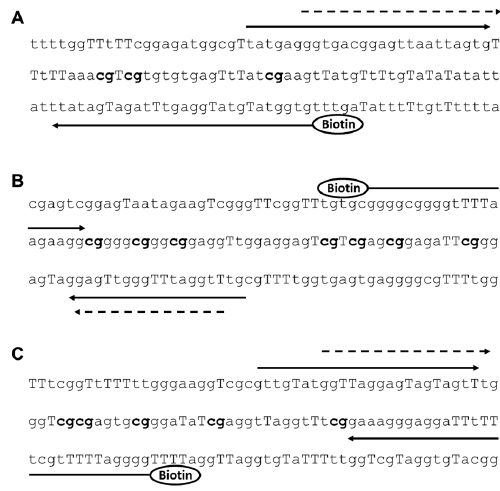
Figure 6. Primer design for each of the pyrosequencing assays. PCR Primes are denoted as solid arrows and sequencing primers as dashed arrows. Uppercase T denotes cytosines, which have been converted to uracil during the sodium bisulfite treatment. The CpG sites analyzed are indicated in bold. ( A ) ELMO1 ; ( B ) ELMO2 ; ( C ) ELMO3 . Table 3. Primer sequences and details of the pyrosequencing assays.